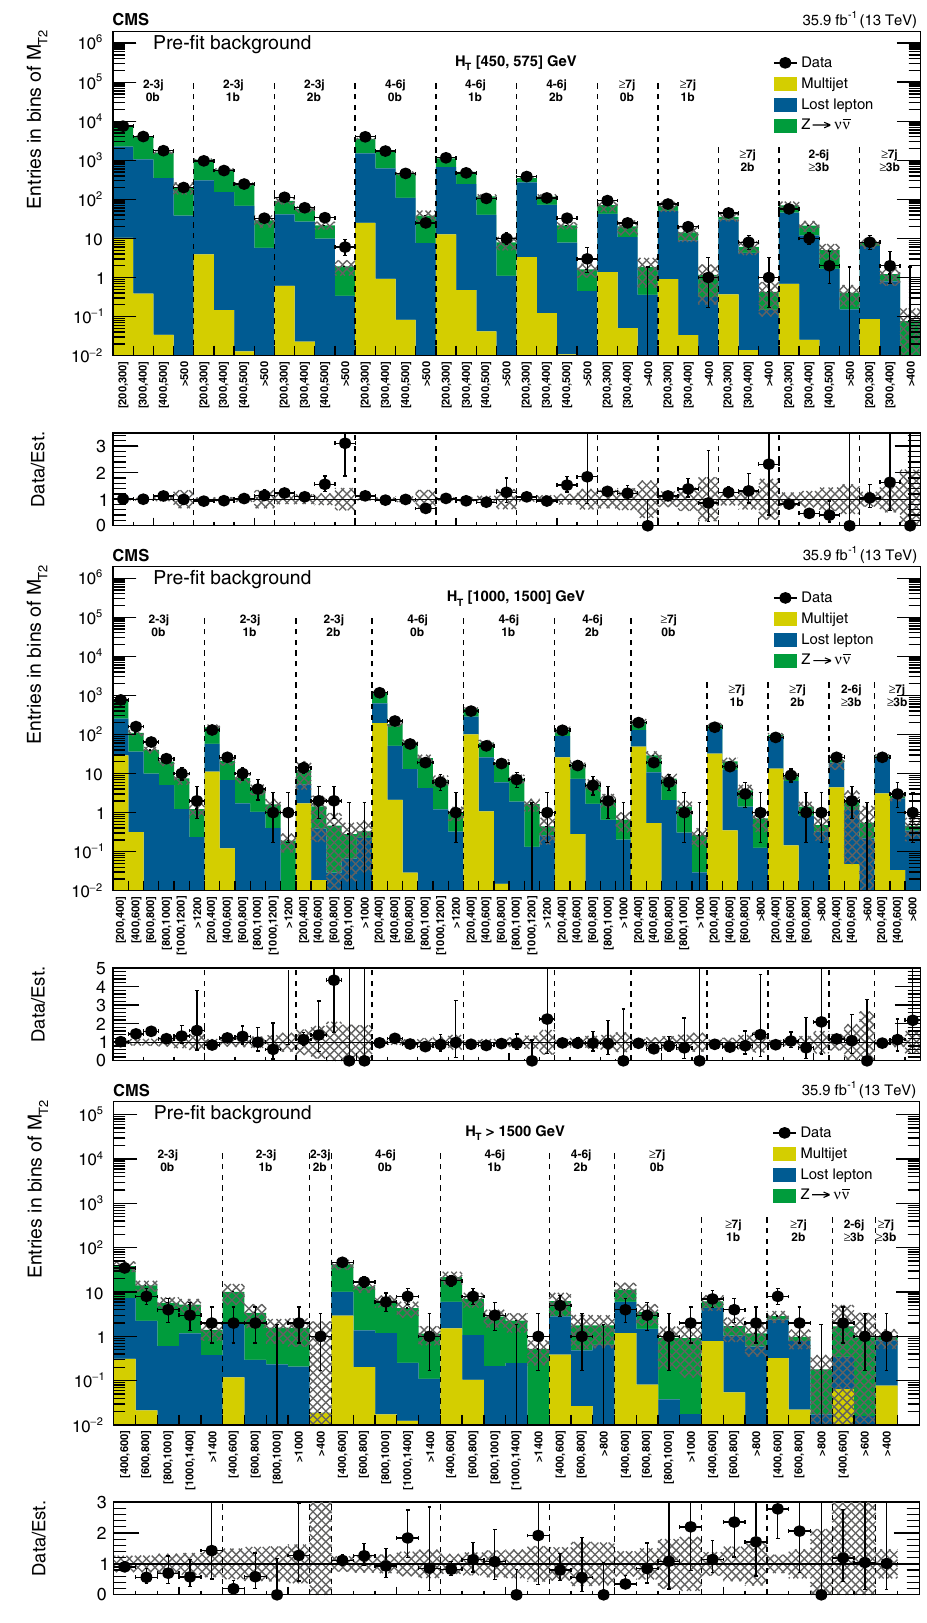
Fig. 10 (Upper) Comparison of the estimated background and observed data events in each signal bin in the low- H T region. Hatched bands represent the full uncertainty in the background estimate. Same for the high- (middle) and extreme- (lower) H T regions. On the x -axis, the M T2 binning is shown in units of GeV. For the extreme- H T region, the last bin is left empty for visualization